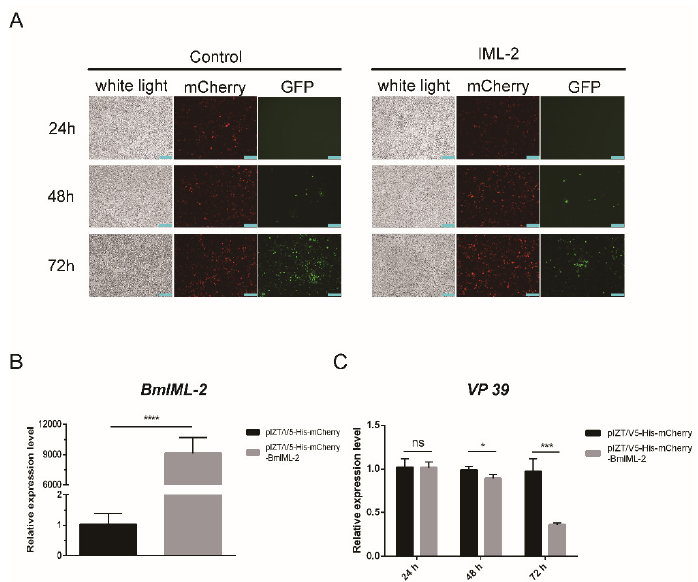
Figure 4. Effects of BmNPV infection and replication by overexpression of BmIML-2 in BmN cells. ( A ) The infected cells after overexpression were observed under fluorescence microscope. White light, optical transmission; GFP, green ; mCherry, red ; scale bar = 200 µm. ( B ) Transcript level analysis of BmIML-2 at 48 h after transfection of the overexpression vector. ( C ) Transcript level analysis of VP 39 after overexpression of BmIML-2 at different times. Data were calibrated by using BmGAPDH and presented as means ± S.D. of three separate experiments. Asterisks represent significant differences compared the control (unpaired t -test; *, p < 0.05; ***, p < 0.001; ****, p < 0.0001; ns, not significant).